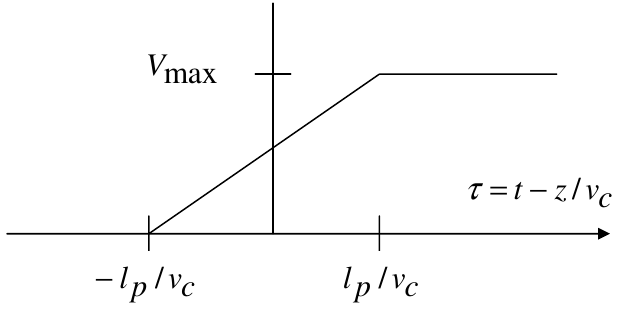
FIG. 10. Voltage waveform launched on a helix by a step function voltage applied to the primary of the